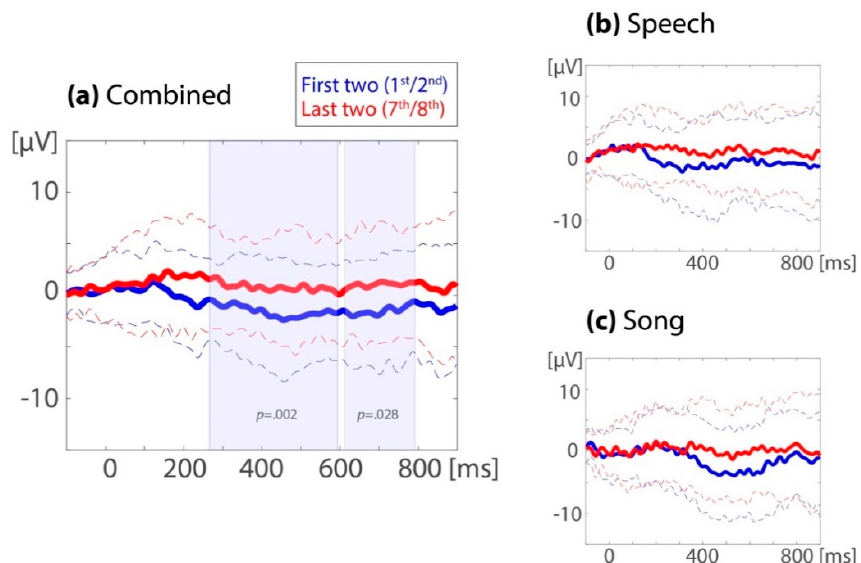
Figure 3. Familiarity effect in the familiarization phase for the combined sessions (32 subjects). Topographic isovoltage maps of the difference between the last two target occurrences (7th/8th) and the first two target occurrences (1st/2nd), in the ( a ) 250–500 ms and ( b ) 600–800 ms latency ranges. Electrodes that are part of output clusters in the cluster randomization test are shown with stars. The red circles indicate electrodes that are part of the left-frontal region of interest.